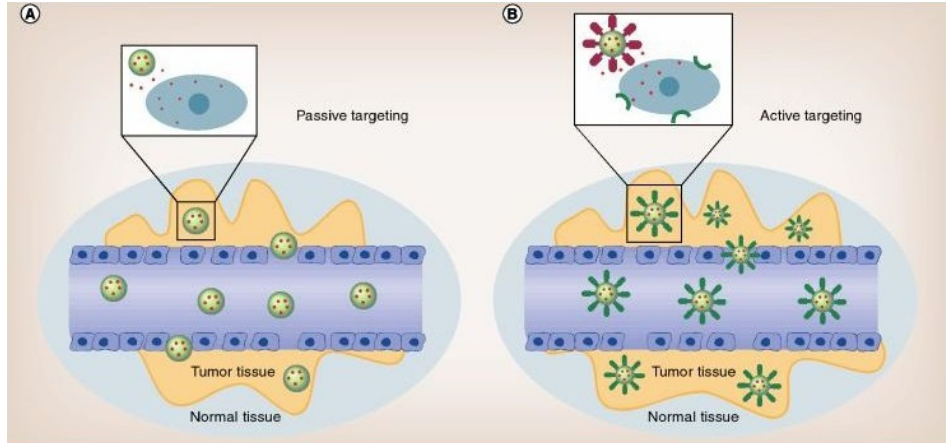
Figure 1. Schematic of passive ( A ) vs. active ( B ) targeting in cancer diagnostic, imaging and therapy. Reproduced with permission from ref. [61]; Boateng et al., Int. J. Mol. Sci. 21 (2020) 273. (open access Creative Common